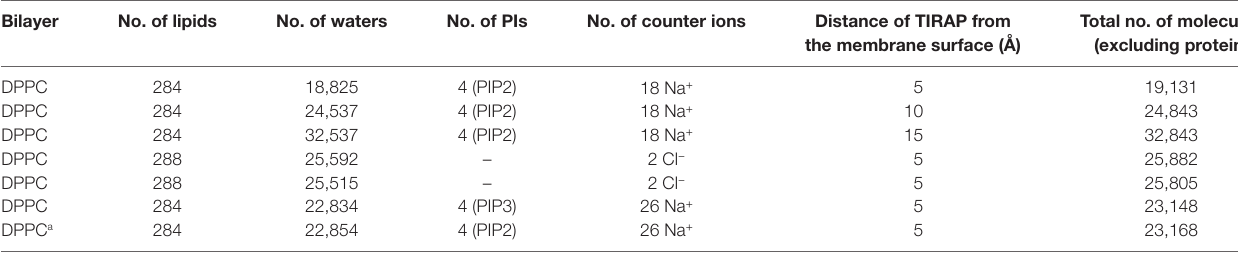
TaBle 1 | The molecular composition of different MD simulations performed in our